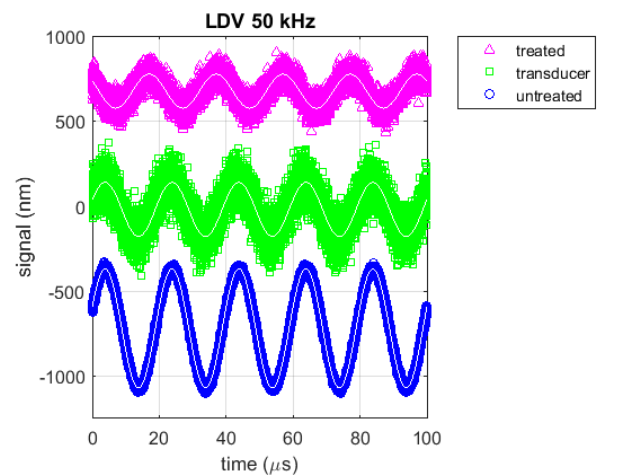
Figure 5. Signal from Doppler